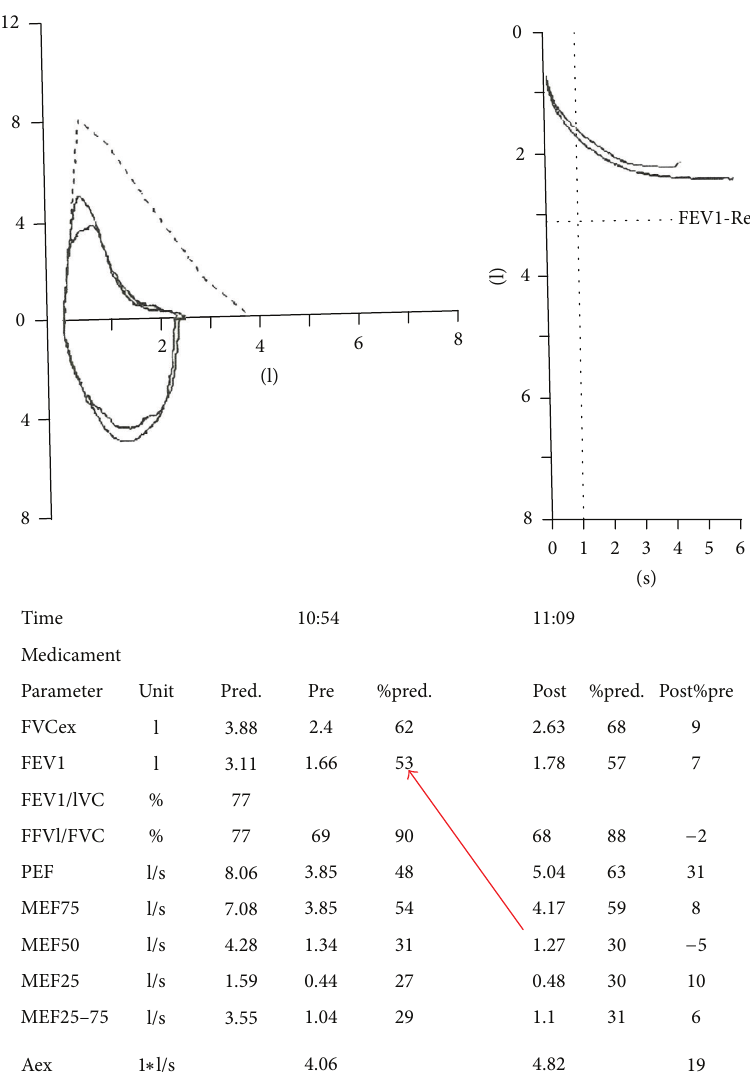
Figure 1: Pulmonary function test showed FEV1—53% (red arrow).